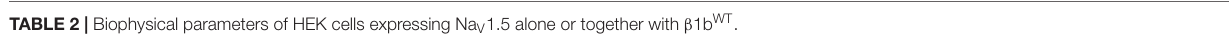
TABLE 2 | Biophysical parameters of HEK cells expressing Na V 1.5 alone or together with β 1b WT . Peak I Na density Activation Steady-state inactivation Recovery